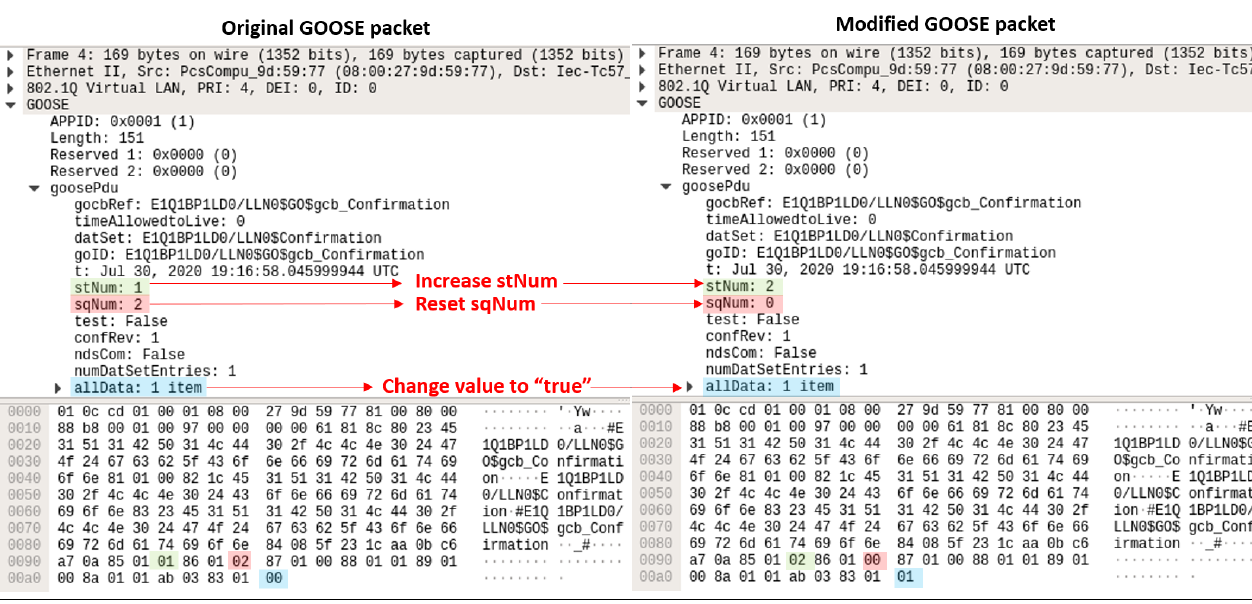
Figure 7. An example of GOOSE spoofing attack